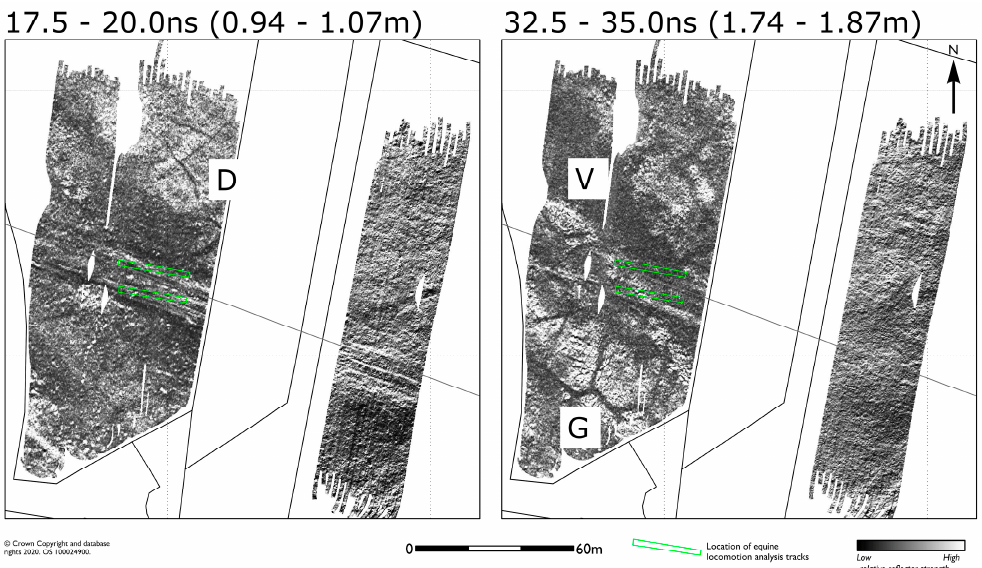
Figure 7. GPR amplitude timeslices from between 17.5 and 20.0 ns (0.94 to 1.07 m), and between 32.5 and 35.0 ns (1.74 to 1.87 m) illustrating the variation in survival and approximate depth of the Roman road. A system of enclosure ditches (D) are found to the north of the Roman road, together with possible geomorphological features (G) and a deeper dry valley (V).